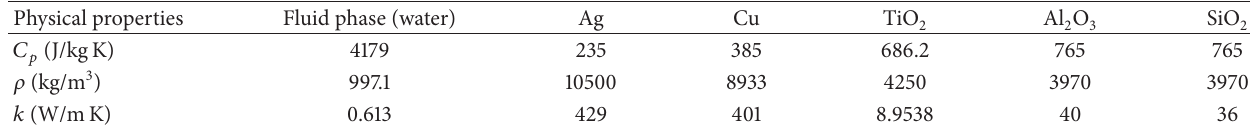
Table 1: Thermophysical properties of the base fluid and nanoparticles